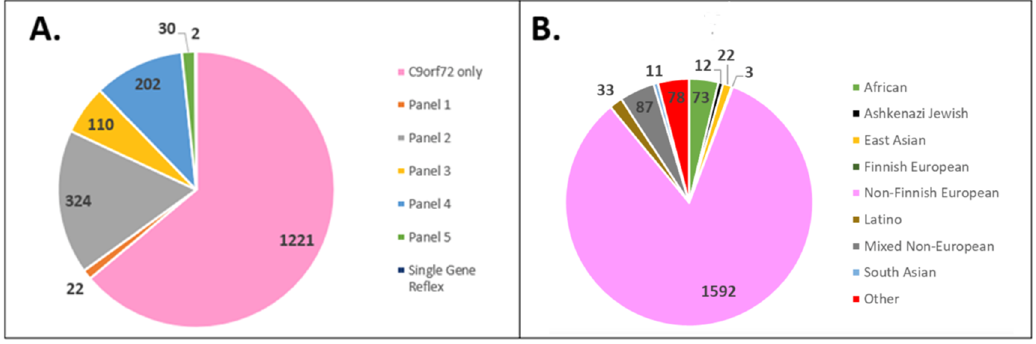
Figure 1. ( A ) Distribution of tests ordered (panel genes listed in Table 1). ( B ) Cohort REA distribu-